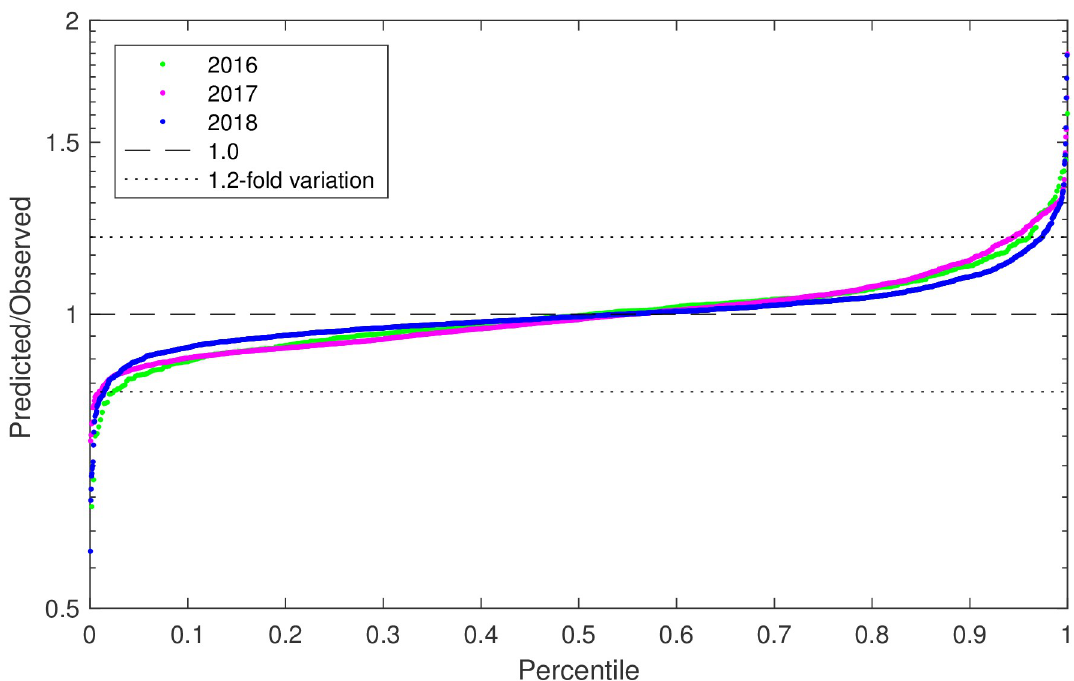
Fig 3. Distribution of residuals for fluorescein calibrants. Model fit residual distribution for every set of fluorescein replicates included in calibration computations for the 2016, 2017, and 2018 studies. Distributions for all three studies are similar, all indicating a high degree of